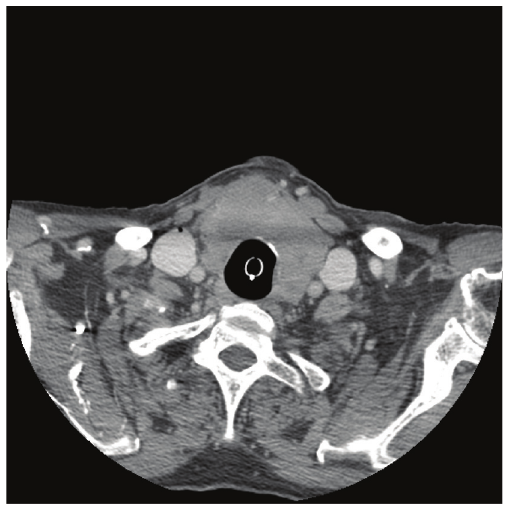
Figure 1: Thyroid mass at largest diameter of 3 × 4cm. Figure 2: Thyroid mass at the level of the inflated endotracheal tube cu ff ; the cu ff at this level is presumed to be stenting the tracheal airway surrounding the tube. Due to the emergent nature of the case, an extubated radiograph was unable to be